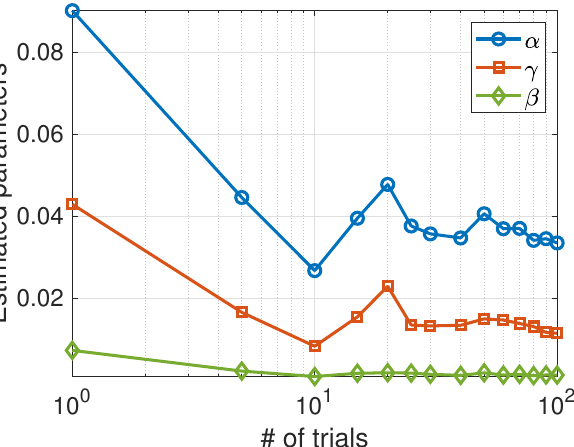
Figure 4. Average values of the parameters estimated using the Nelder–Mead algorithm as a function of the number of